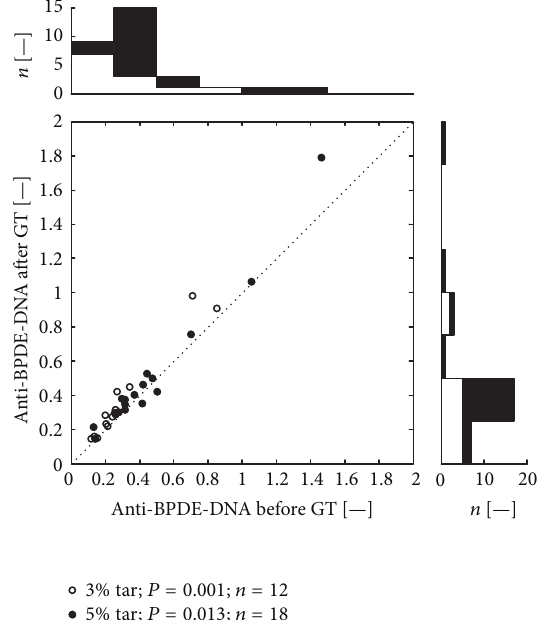
Figure2:Distributionofvaluesofanti-BPDE-DNA(non-smokers). Legend: Scatter plot depicts anti-BPDE-DNA values before and after the GT therapy. All together 30 dots represent 60 measurements, each dot belongs to a one